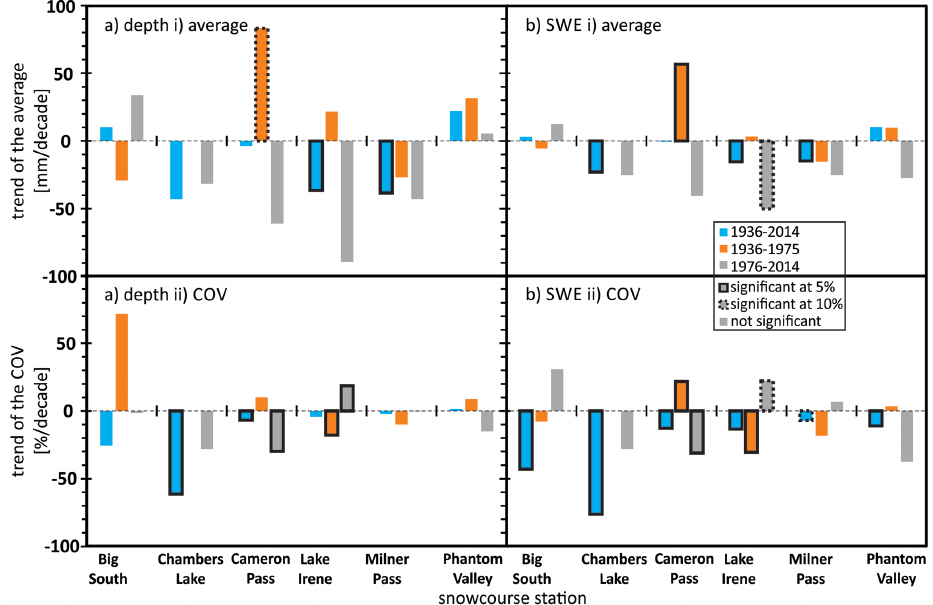
Figure 2. Summary of (a) snow depth and (b) SWE trends for the six stations over the entire period of record (1936–2014) and the two halves (1936–1975, 1976–2014) for (i) the average and (ii) the coefficient of variation. Trends are significant at the 5% (solid outline) or 10% (dashed outline) level. Non-significant trends have no